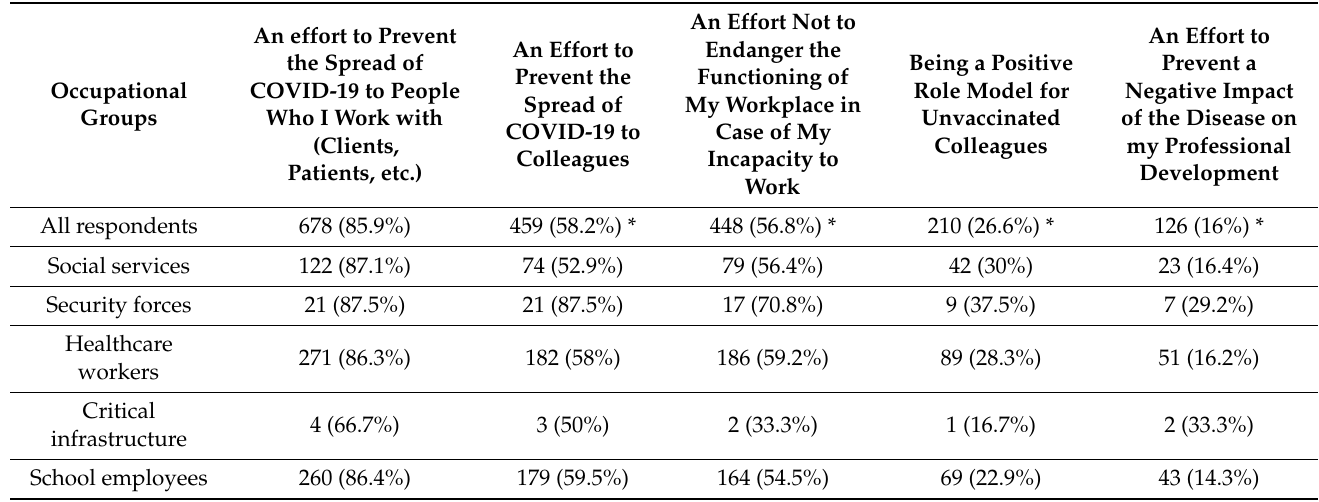
Table 3. Detailed profession-oriented motives for vaccination